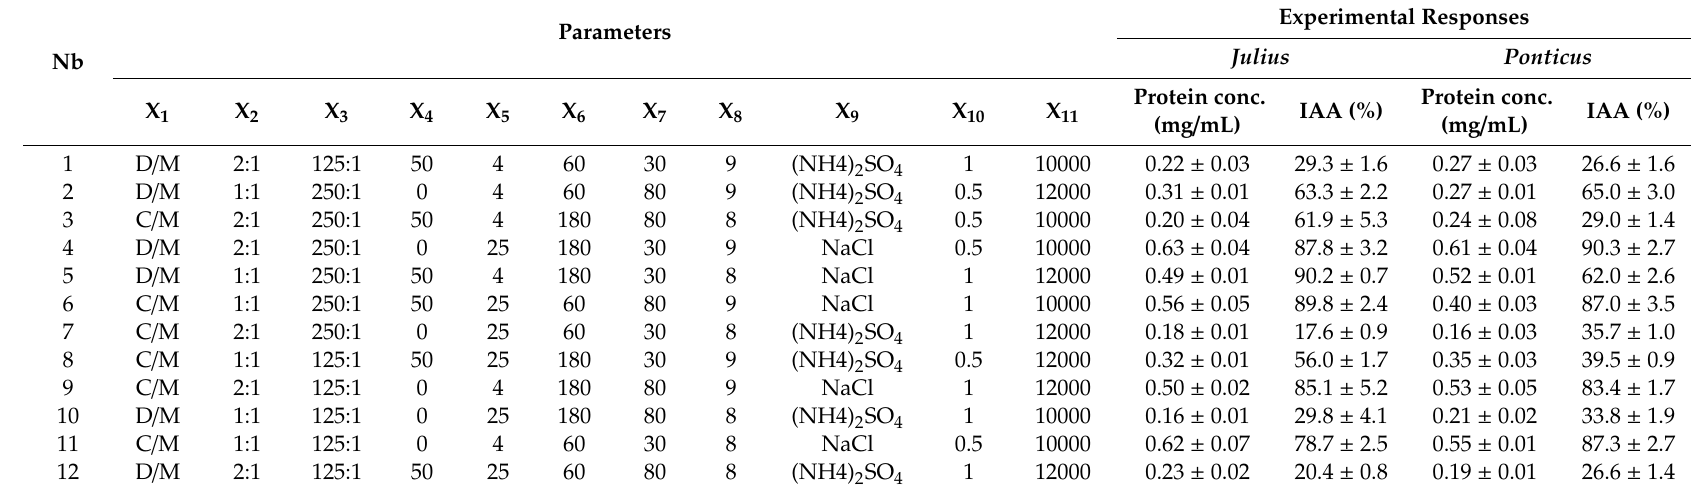
Table 1. Plackett-Burman design presenting the eleven factors and the two corresponding experimental responses for the Julius and Ponticus